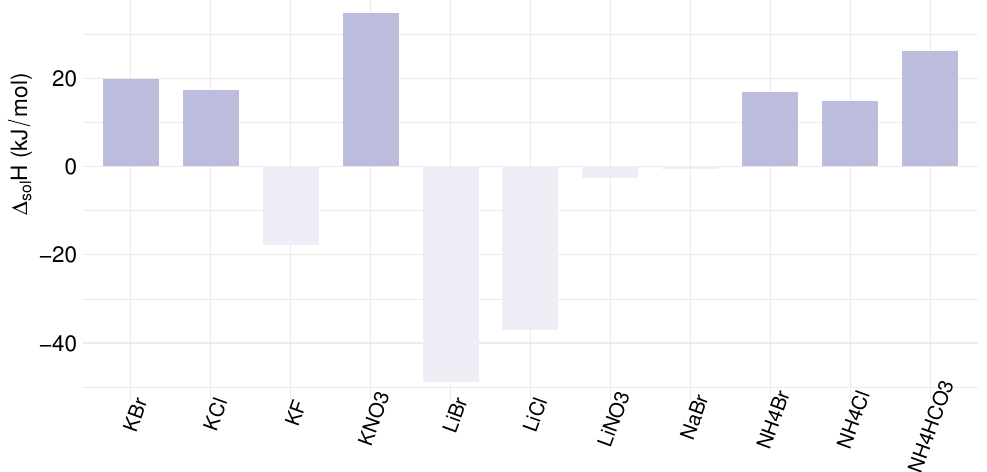
Figure 8. Enthalpy of dissolution for various salts at infinite dilution. The dark purple bars represent salts with an endothermic enthalpy of dissolution, while the light purple bars represent salts with an exothermic enthalpy of dissolution. Data extracted from